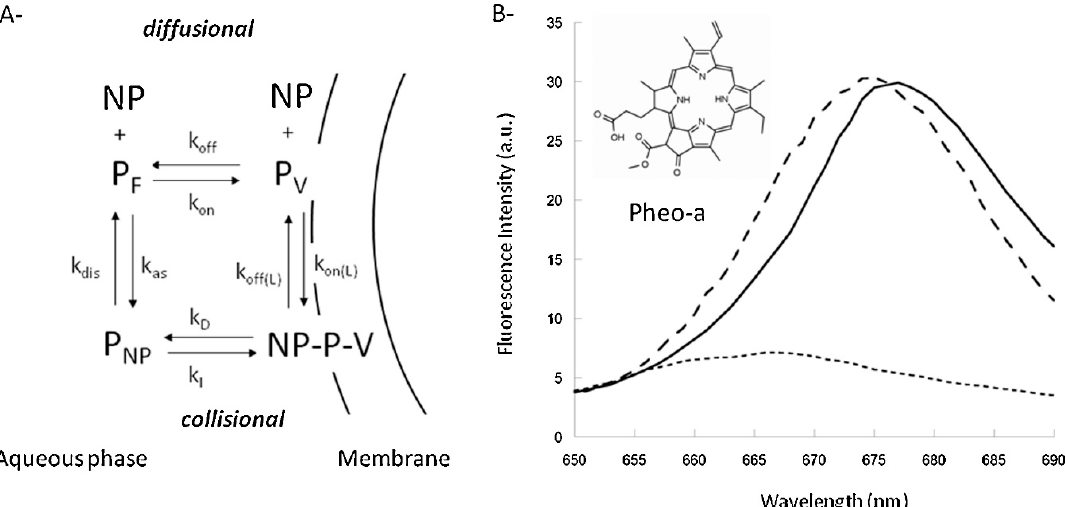
Figure 5. ( A ) Uptake of Pheophorbide-a (Pheo) loaded, PEO-b-PCL micelles might follow the collisional or diffusional kinetic mechanism. Which describes the free aqueous concentration of nanoparticles (NP), Pheo (PF), vesicles (V); Pheo associated to nanoparticles (PNP), vesicles (PV) and the Pheo-Nanoparticle-Vesicle complex (NP-P-V). ( B ) Pheo shows a different emission spectrum when present in DOPC vesicles (solid), nanoparticles (dashed) or phosphate buffered salin (PBS) (dotted), which can be used to investigate the uptake mechanisms of PEO-b-PCL micelles (reprinted from Reference [111] with permission from Elsevier).